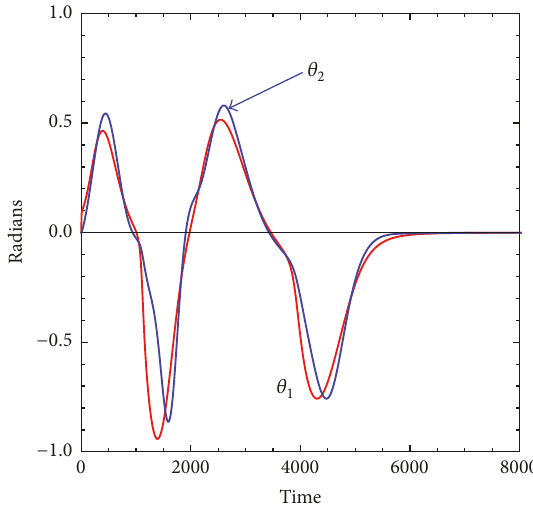
Figure 7: Orientations of A 1 and A 2 for Scenario 1.